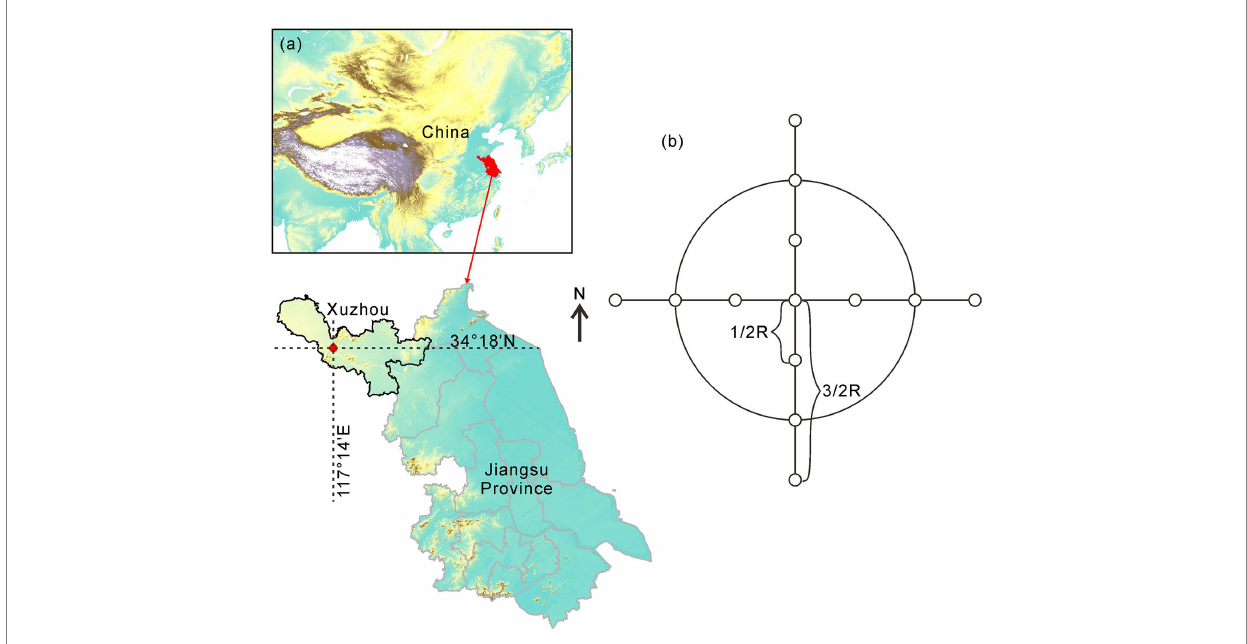
FIGURE 1 (A) Study site (B) Experimental design. The small circles represent sampling points.